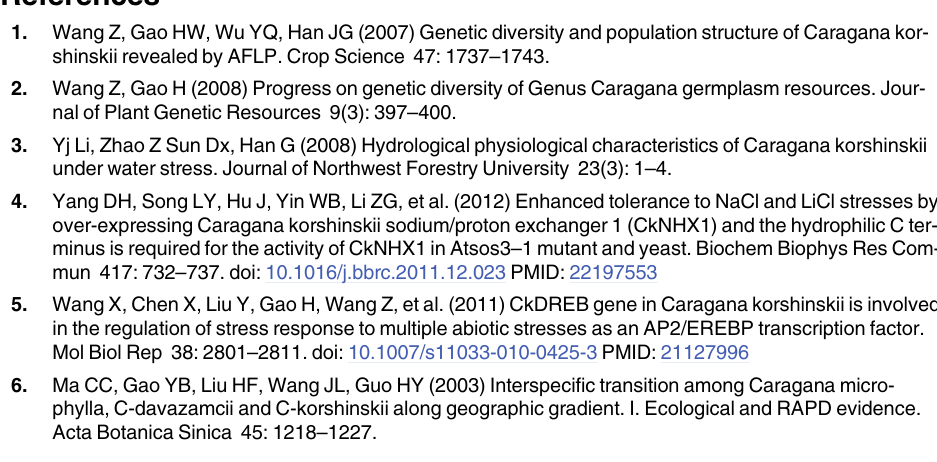
S1 Fig. Length distribution of assembly transcripts and unigenes. S1 Table. Summary of the GO classification of assembled unigenes. S2 Table. Summary of the KEGG classification of assembled unigenes. S3 Table. Primer information for EST-SSR